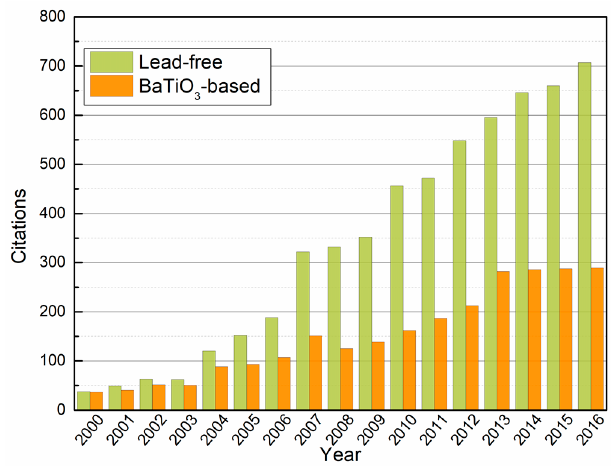
Figure 1. The publication number relates with Pb-free and BaTiO 3 -based piezoelectrics.